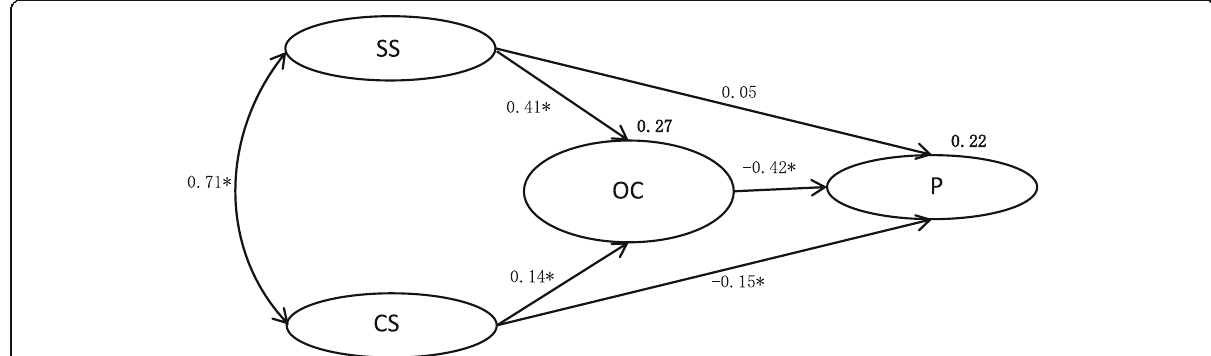
Fig. 2 Final structural equation model, with standardized maximum likelihood estimates (* p < 0.001; numbers not in bold are standardized regression coefficients and numbers in bold explain